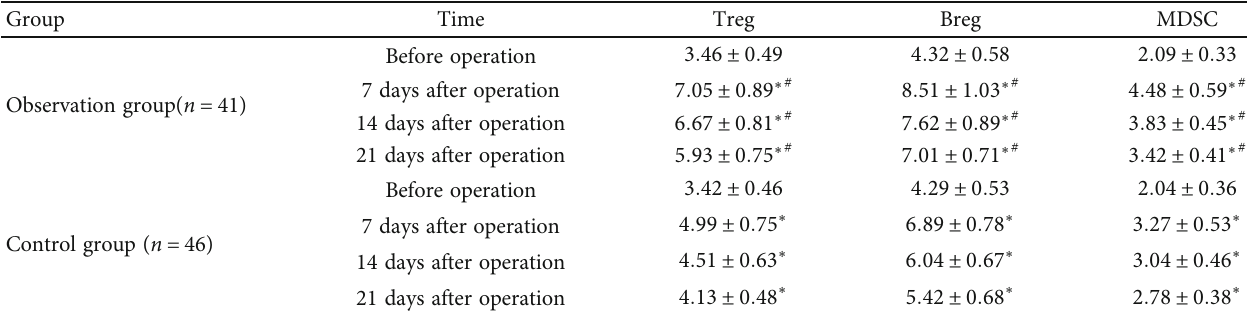
Table 4: Comparison of the content of immune cells in peripheral blood in di ff erent